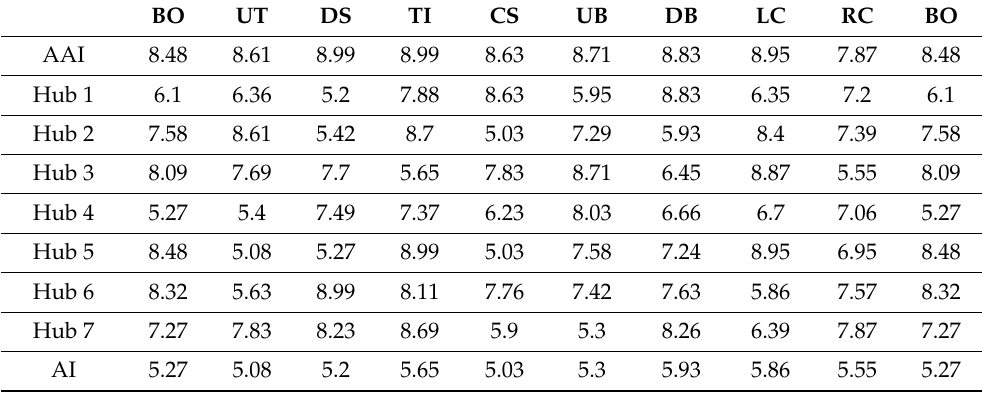
Table 9. The initial decision matrix.